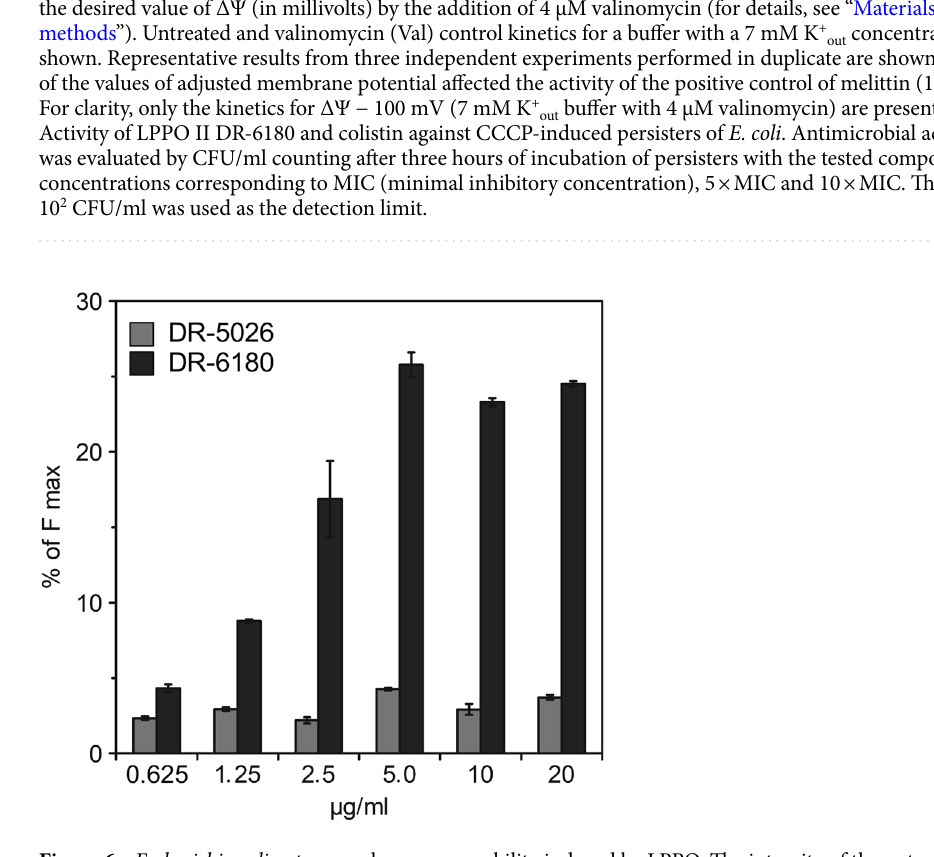
Figure 6. Escherichia coli outer membrane permeability induced by LPPO. The integrity of the outer membrane was assessed by measuring the increase in fluorescence intensity due to NPN uptake by cells with a compromised outer membrane induced by LPPO. The data represent the percentage of fluorescence intensity from the entire kinetics plot after reaching the plateau relative to the maximum induced by the addition of 100 µM polymyxin